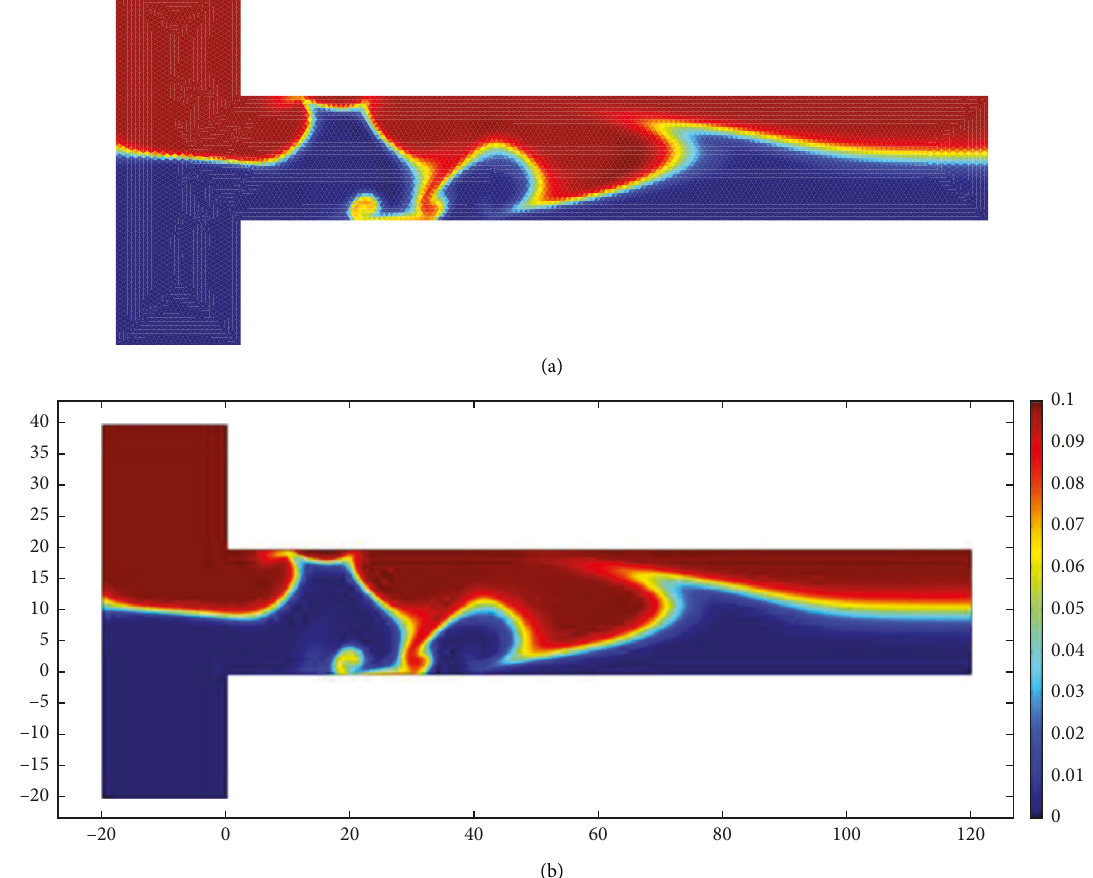
Figure 4: Concentration contours under sinusoidal potential at 100Hz and t � 0.02/3 s in the (a) present study and (b) Cheng et al. [22].